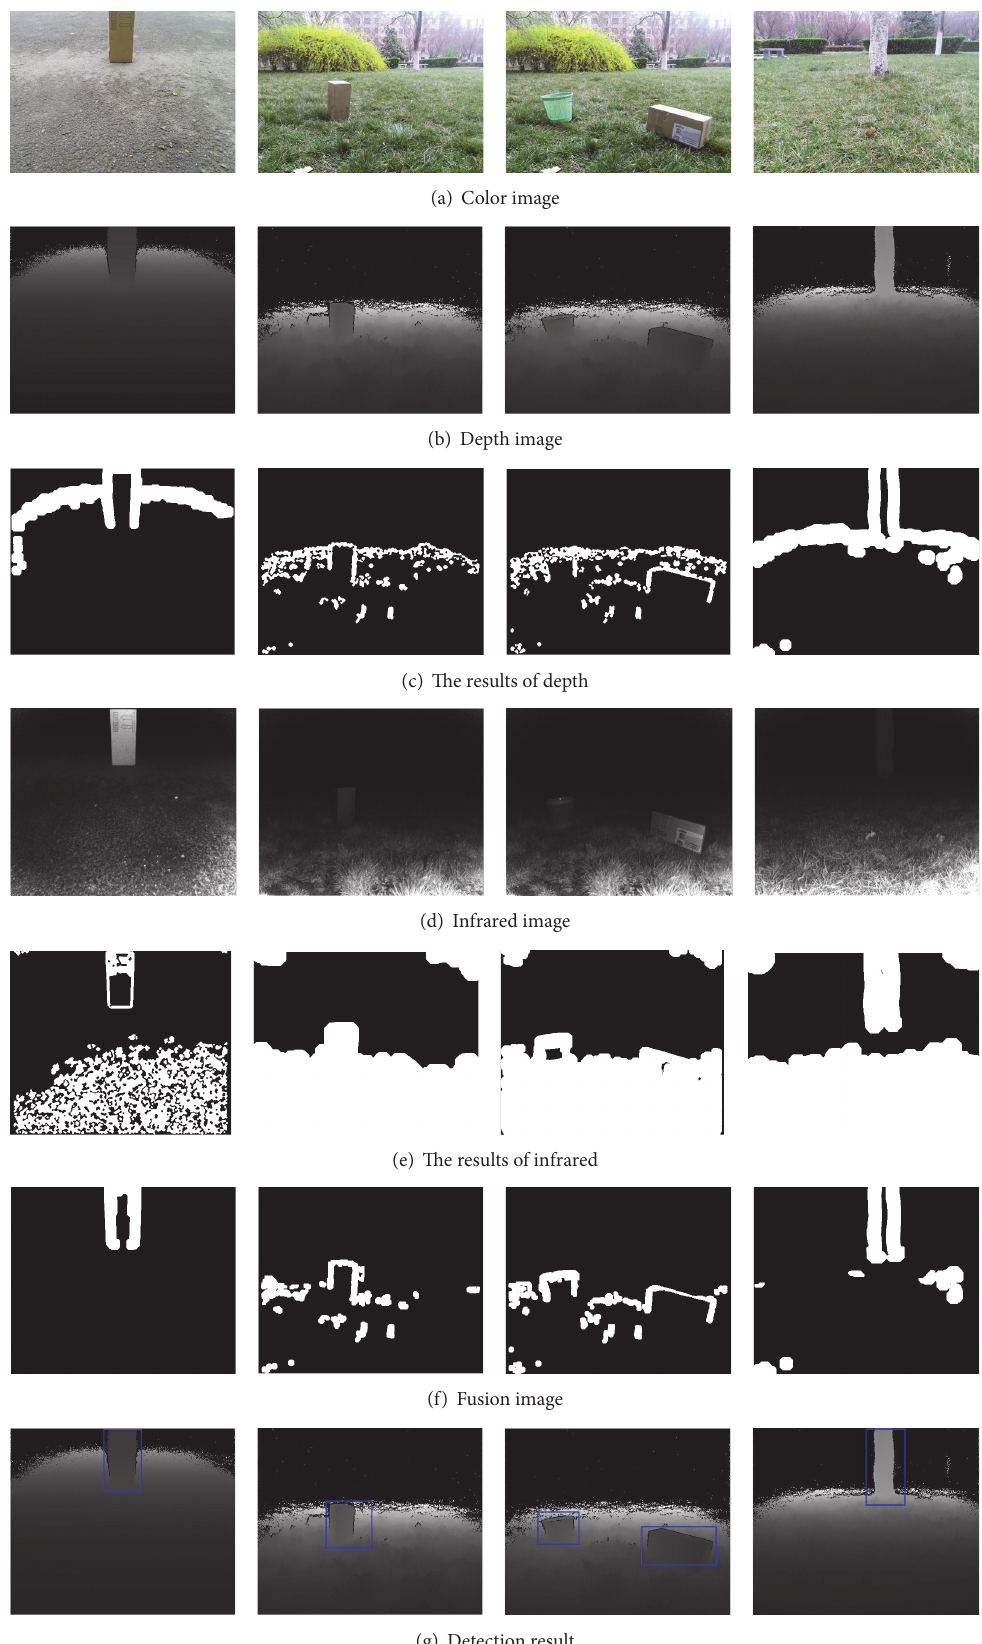
Figure 8: Results of obstacle